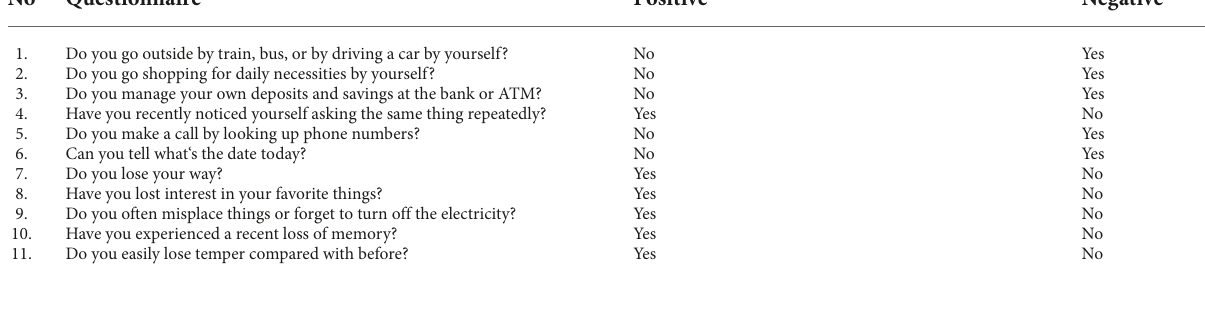
TABLE 1 List of self-reporting yes/no surveys to detect